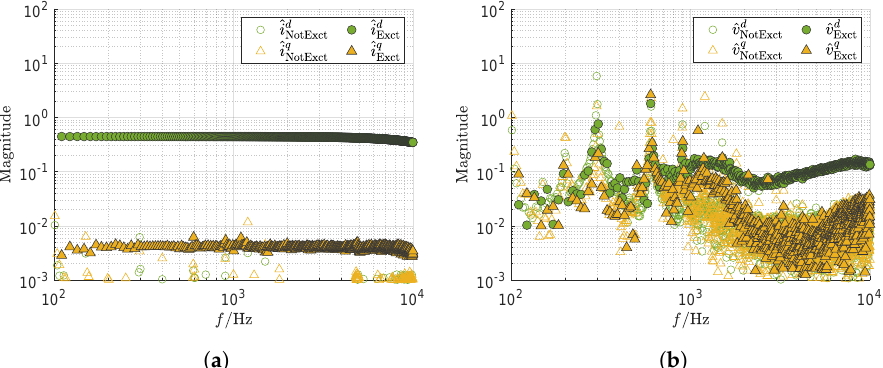
Figure 24. Measurement of the industrial power grid during excitation of the d -axis. ( a ) Spectrum of the current i meas in the dq domain. ( b ) Spectrum of the voltage v meas in the dq